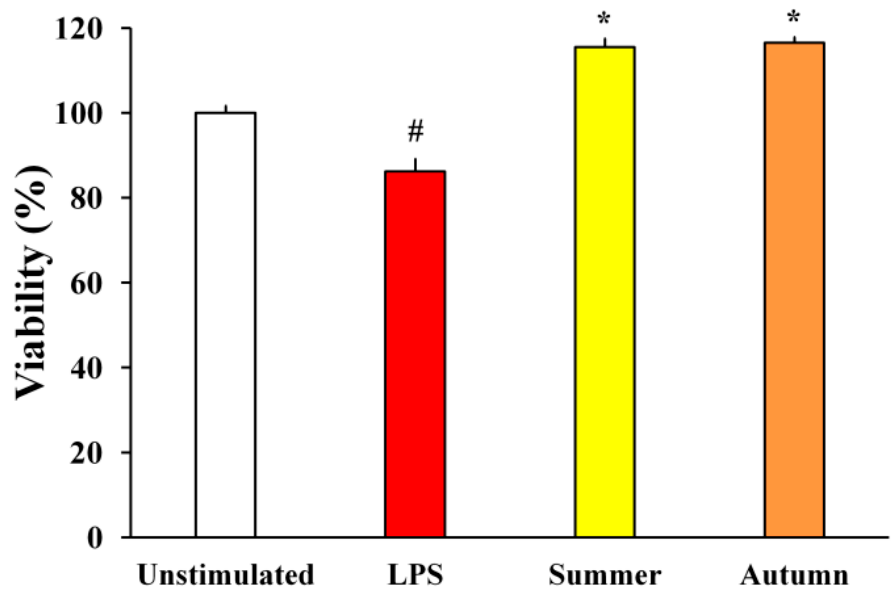
Figure 4. The effects of LPS-stimulated and moss-treated supernatants of BV2 cells on SH-SY5Y metabolic activity. The results are presented as the mean ± standard error (# p < 0.05 unstimulated cells vs. LPS-stimulated; * p < 0.05 LPS-stimulated vs. moss-treated and LPS-stimulated cells).